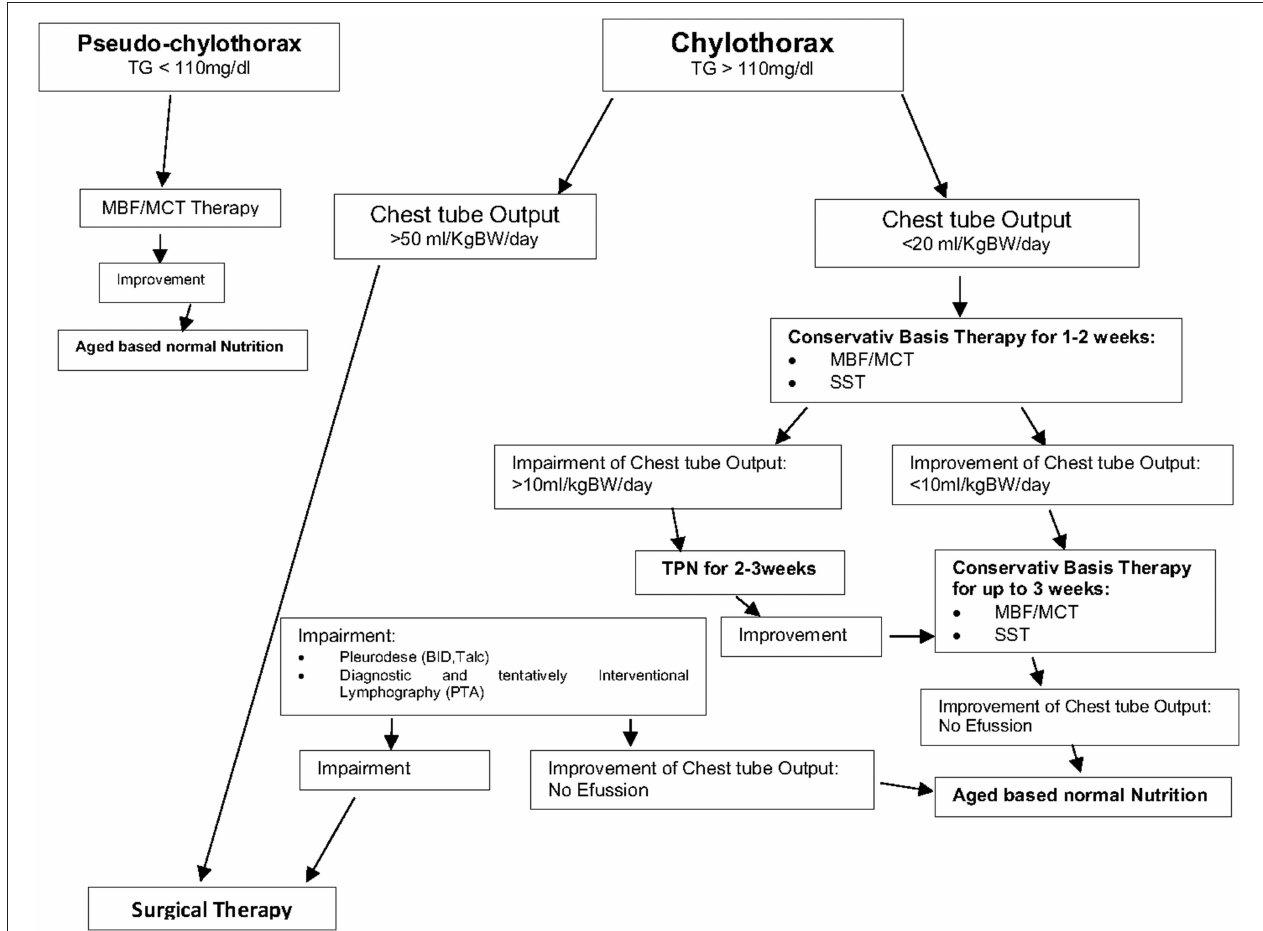
FIGURE 3 | Therapy of chylothorax and chylous like diseases—Clinical Algorithm modified